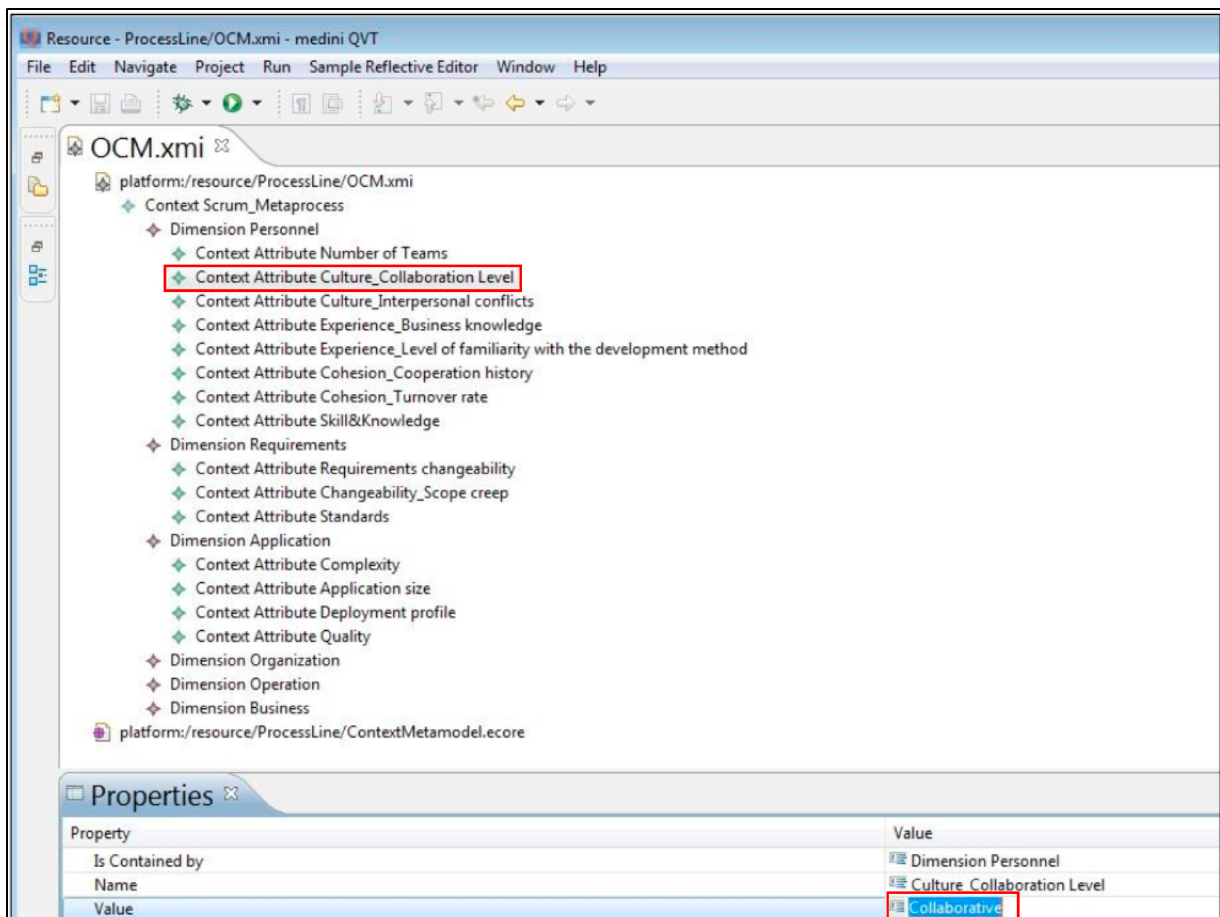
Figure A6. The Organizational Context Model (OCM) implemented in the tool.